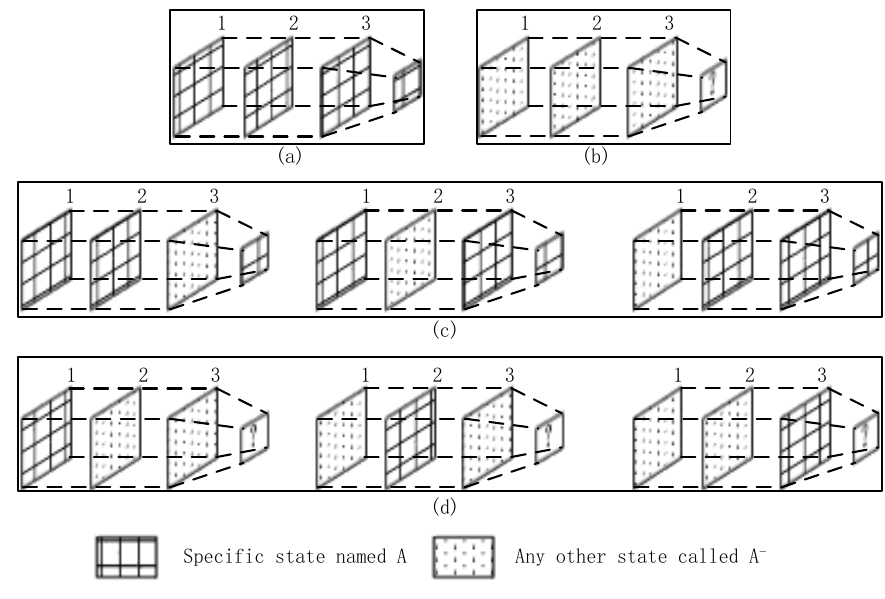
Figure 5. Circumstances of a certain state.